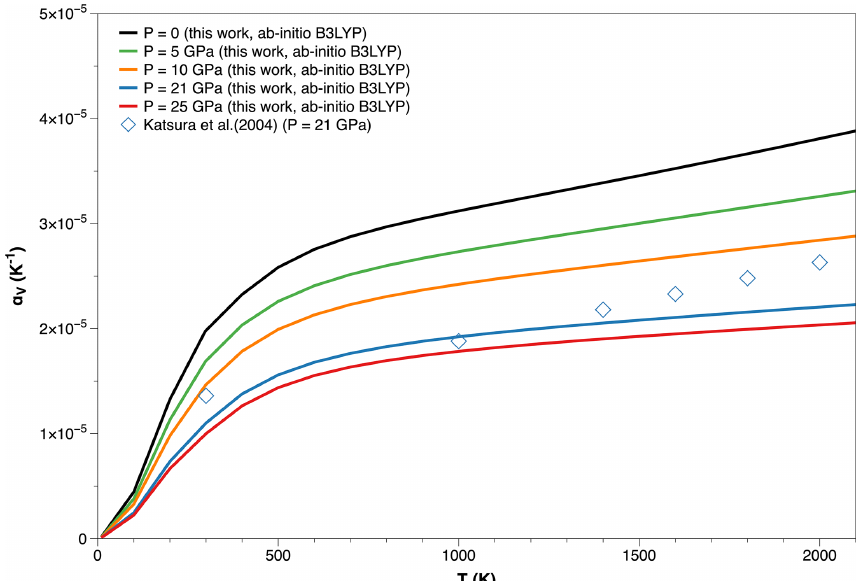
Figure 5. Ab initio volume thermal expansivity ( α V ) of Mg 2 SiO 4 ringwoodite at different pressures ( P = 0, 5, 10, 21 and 25GPa). Experi- mental data at P = 21GPa are from Katsura et al.